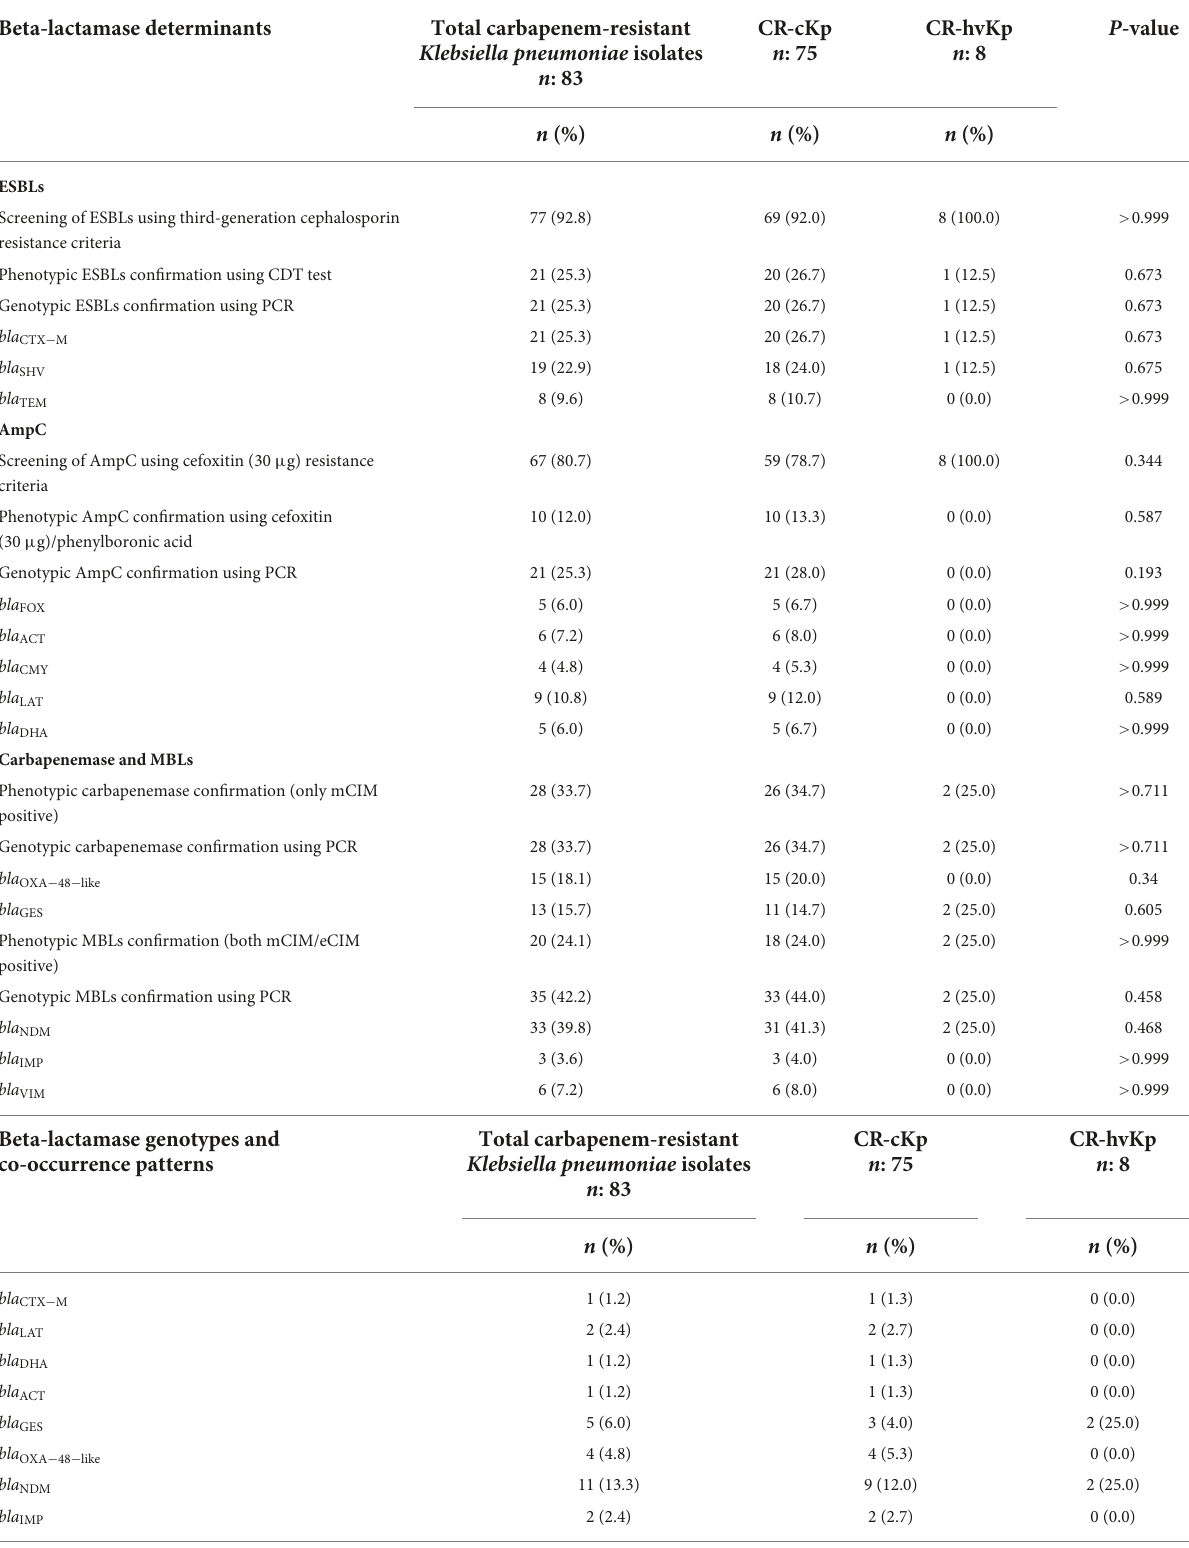
TABLE 5 Prevalence of beta-lactamase determinants and their genotypes in carbapenem-resistant classic Klebsiella pneumoniae (CR-cKp) and carbapenem-resistant hypervirulent K. pneumoniae (CR-hvKp) isolates. Beta-lactamase determinants Total carbapenem-resistant Klebsiella pneumoniae